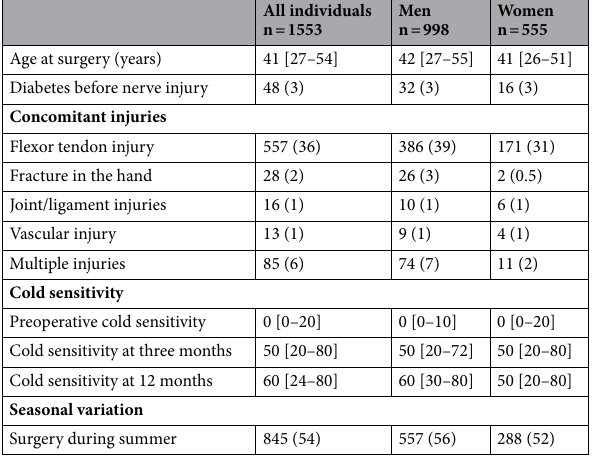
Table 1. Characteristics and cold sensitivity scores of individuals treated with repair of a digital nerve injury. Values are presented as n (%) or median [IQR; interquartile range]. Cold sensitivity scores from HAKIR questionnaire preoperatively as well as three and 12 months postoperatively.